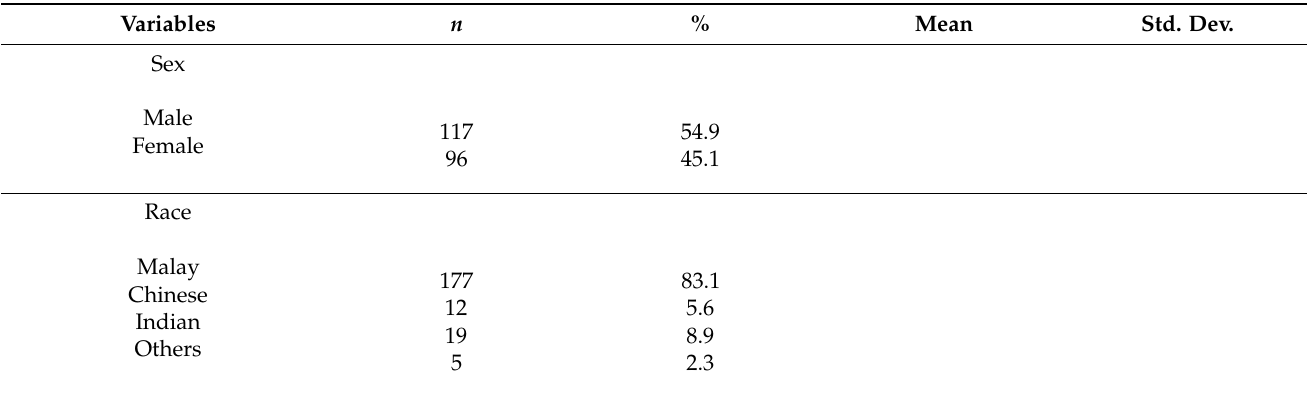
Table 1. Socio-demographic profile of participants ( n =